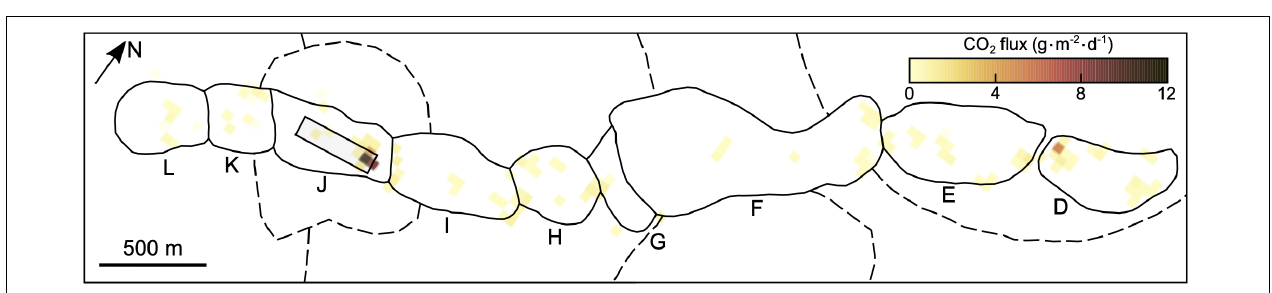
FIGURE 6 | Tarawera CO 2 flux distribution from sequential Gaussian simulations, where craters (solid black outline) and domes (dashed black outline) are from Sable et al. (2006). Location of Figure 7 shown by gray box.